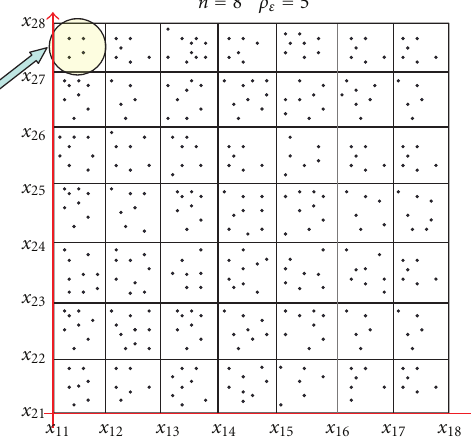
Figure 2: Example of too fine uniform fuzzy partition set.